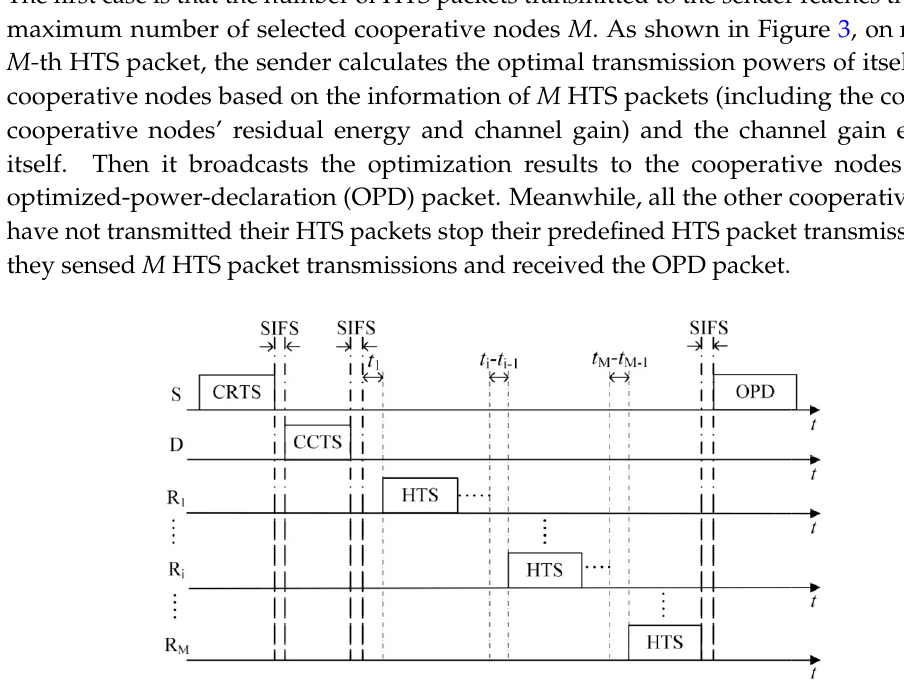
Figure 3. First case of optimal cooperative node group: The number of cooperative nodes reaches M .